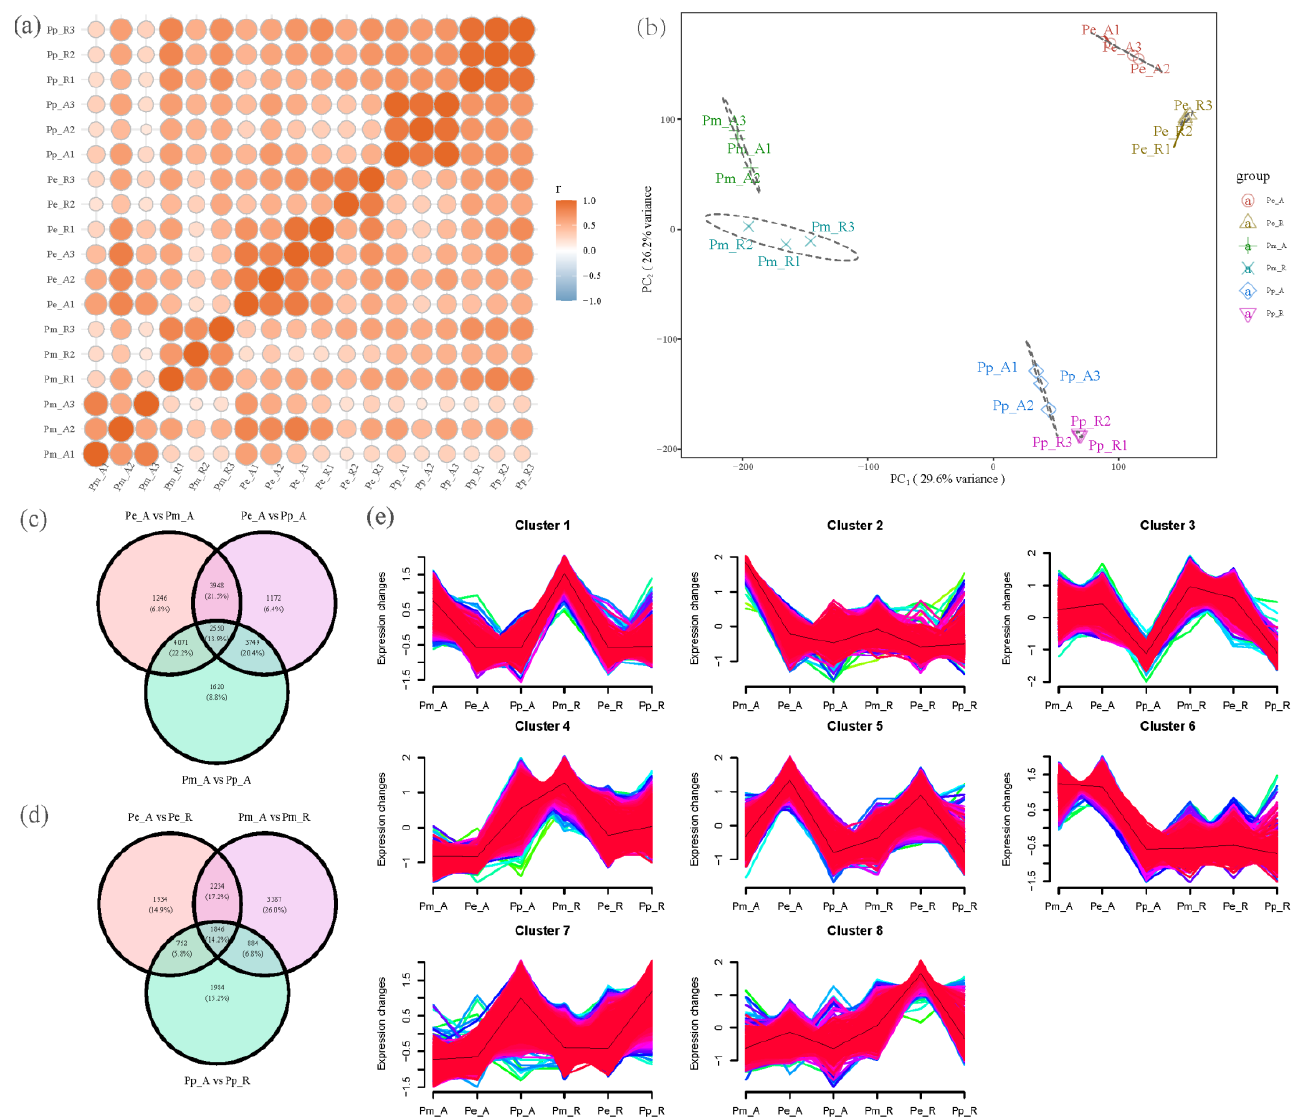
Figure 2. Correlation analysis of transcriptome samples and trend analysis of DEGs. ( a ) Sample correlation heatmap; ( b ) sample PCA analysis; ( c ) Venn diagram of DEGs; ( d ) Venn diagram of DEGs; ( e ) Trend analysis of DEGs by Mfuzz. Note: In (e), the default color palette was used, the black line represented the cluster centre.